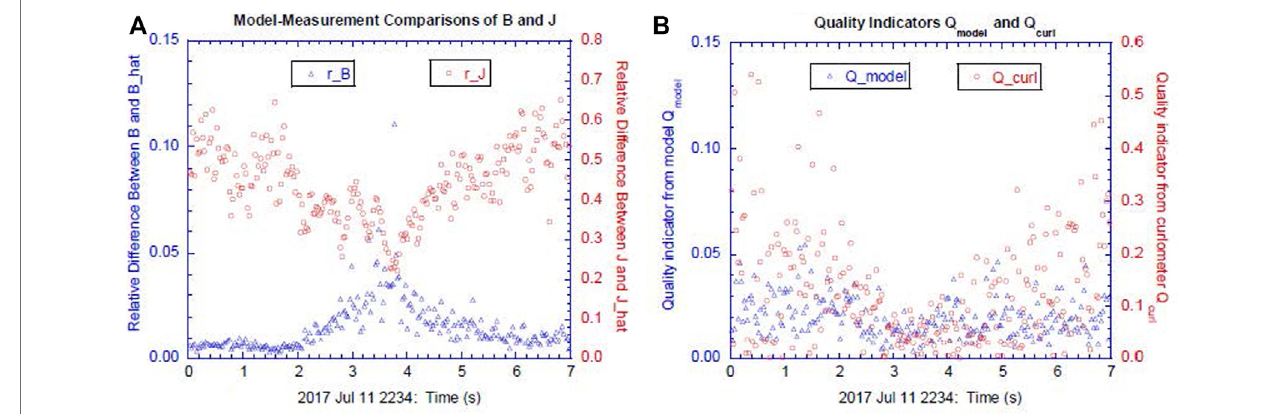
FIGURE 6 | (A) Relative differences ( γ B , γ J ) and (B) quality indicators ( Q model , Q curl ) for a sensitivity run with weighting factors w B and w C being both set to 1: ( w , w ) (cid:1) ( 1 , 1 ) B C